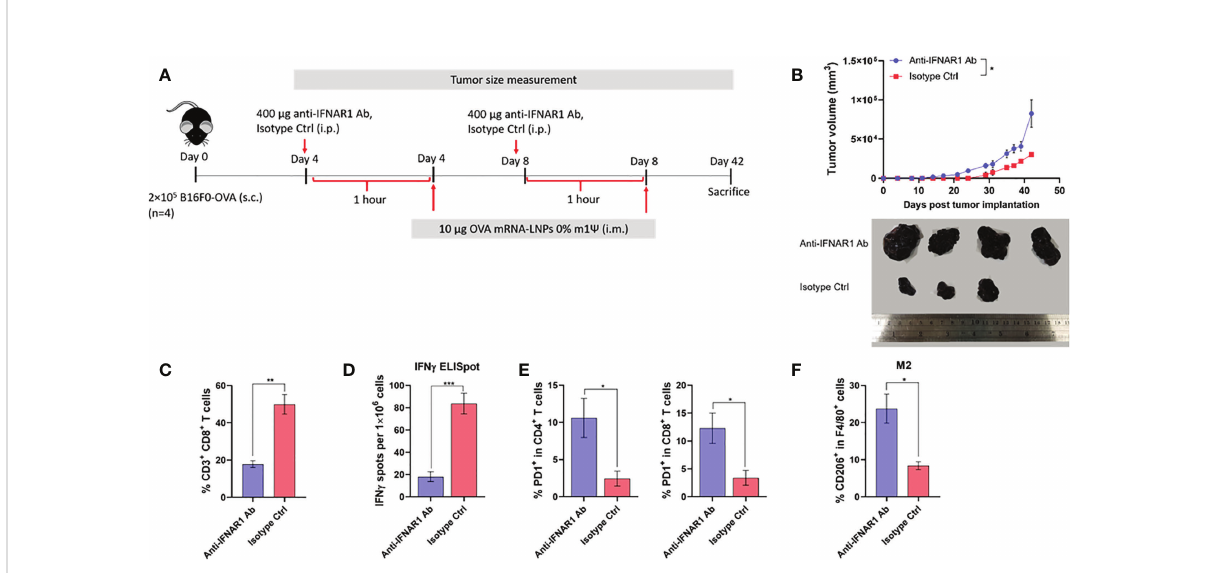
FIGURE 6 Type I IFN signaling promotes antitumor effect and modulated immune cell pro fi le. (A) Scheme of immunization regimen and IFNAR1 antibody or isotype control treatment. See details in methods. (B) The tumor volume (top panel) and the representative tumor mass (lower panel) harvested 42 days after the tumor implantation from mice treated with anti-IFNAR1 antibody or isotype control followed by immunization with unmodi fi ed OVA-LNP. (C) The frequency of splenic CD8 + T cells was examined by fl ow cytometry. (D) ELISpot of IFN- g producing cells among splenocytes after 48 hr of ex vivo re-stimulation with OVA on day 42 after tumor implantation and mRNA vaccine treatments is shown. (E) The frequency of PD-1 + cells among tumor in fi ltrated CD4 + (left) and CD8 + (right) T cells were examined by fl ow cytometry. (F) The frequency of tumor in fi ltrated CD206 + macrophages was determined by fl ow cytometry. The results are presented as the mean ± SEM, n = 4 biologically independent mice per group. Statistical signi fi cance: (*) p < 0.05, (**) p < 0.01, (***) p < 0.001 by unpaired two-tailed Student ’ s t